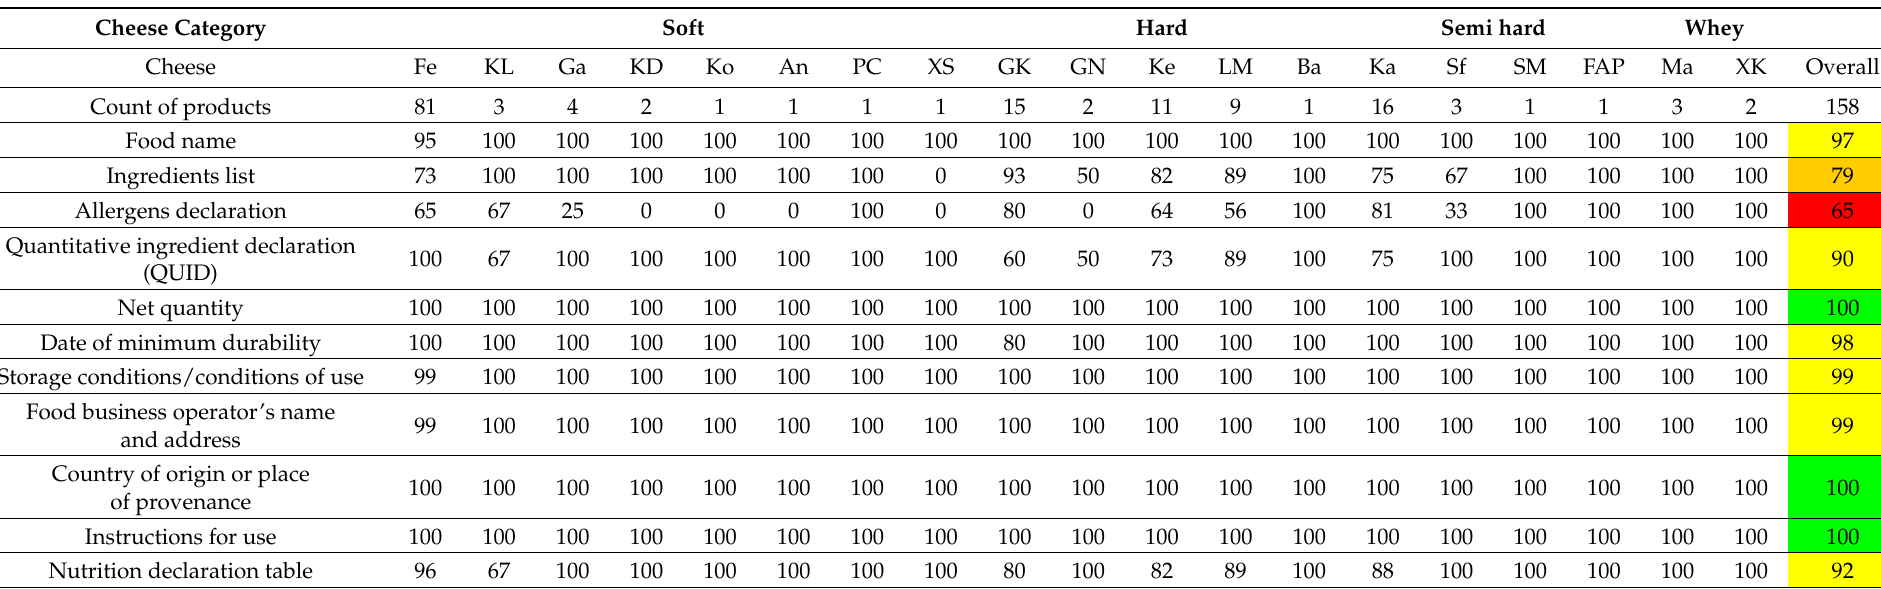
Table 2. Percentage (%) of compliance for eacmandatory labelling indication according to FIC Regulation’s, art. 9, for 158 pre-packed cheese products belonging to 19 cheeses identified in the Greek